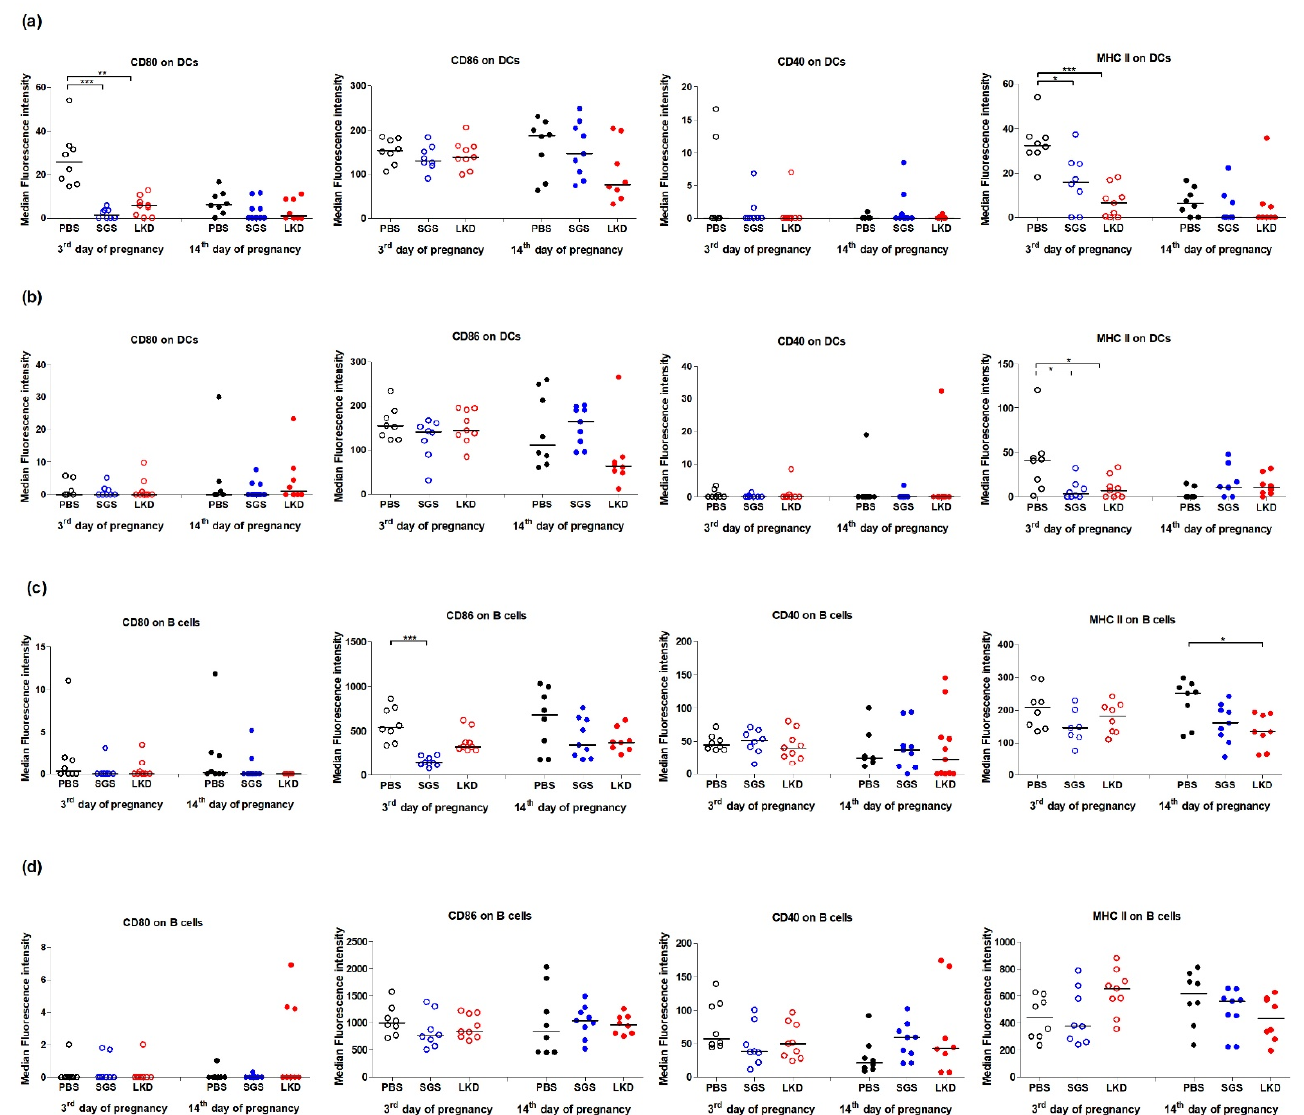
Figure 7. Effect of SGS and LKD on the expression of CD40, CD80, CD86, and major histocompatibility class II proteins on the surface of ( a ) CD11c + splenocytes and ( b ) CD11c + uterine-draining lymph node cells, ( c ) CD19 + splenocytes, and ( d ) CD19 + uterine-draining lymph node cells at 3 dpc and 14 dpc in abortion-prone mice. Data were analyzed using one-way analysis of variance (for normally distributed data), followed by Bonferroni’s multiple comparison post hoc test or the Kruskal–Wallis test (for non-normally distributed data), followed by Dunn’s multiple comparison post hoc test ( p < 0.05). Data are presented as individual values with the median. * p < 0.05, ** p < 0.01, and *** p < 0.001.